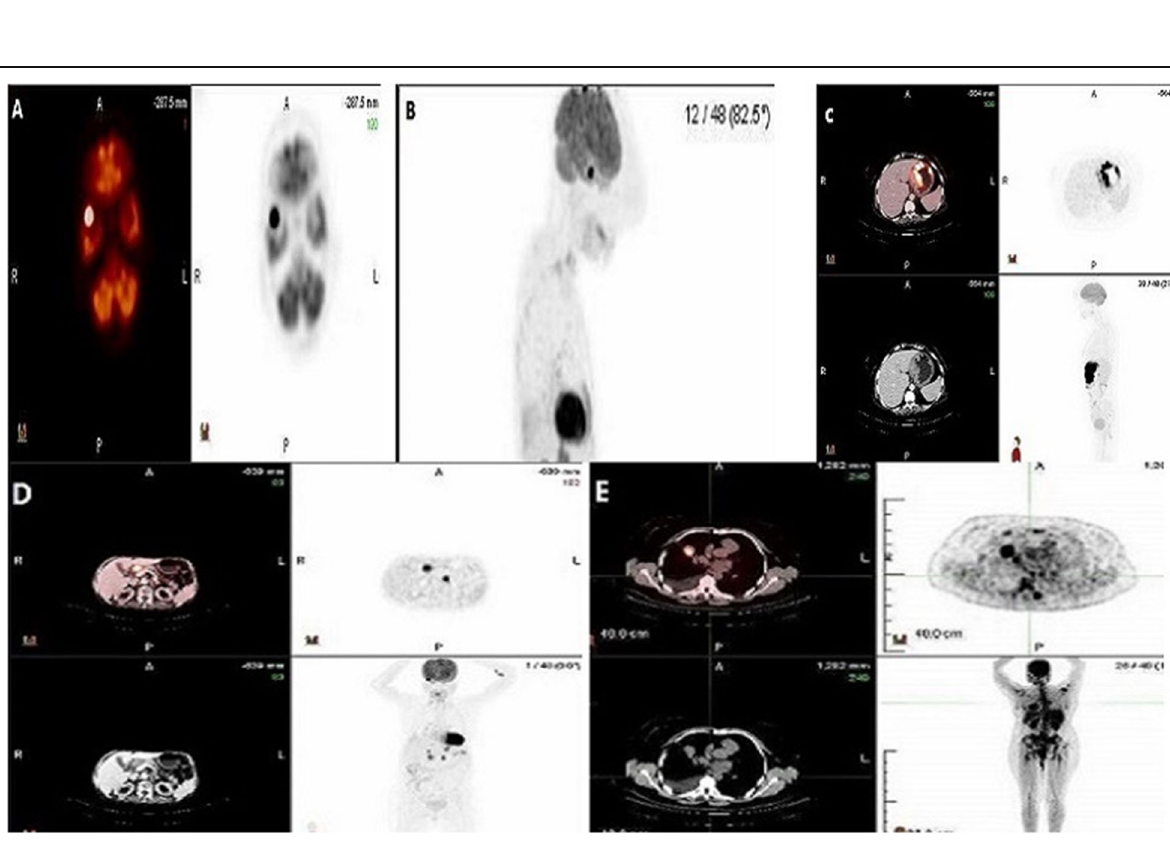
Fig. 3 Right temporal lesion incidentally detected in a female patient aged 57 years by CT scan. a , b Axial fused PET/CT and axial and sagittal PET scan showed a single metastatic mass lesion in the right temporal lobe with active FDG uptake. c Axial fused PET/CT and CT scan showed nodular gastric wall thickness seen mainly in the body with active FDG uptake proved by gastroscopic biopsy to be gastric adenocarcinoma and considered the primary tumor. d Axial fused PET/CT and CT scan showed active porta hepatis and left retrocrual metastatic lymph nodes. e Axial fused PET/CT and CT scan showed another active metastatic mass in the right lung